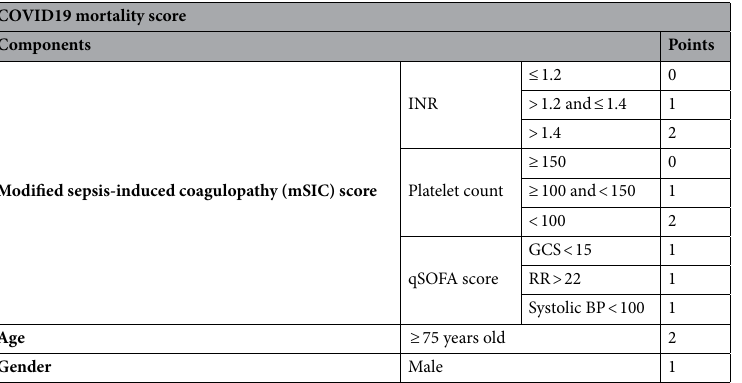
Table 4. The COVID-19 mortality score for predicting 30-day outcome in hospitalised patients. The score is derived from a multivariable regression analysis of independently predictive